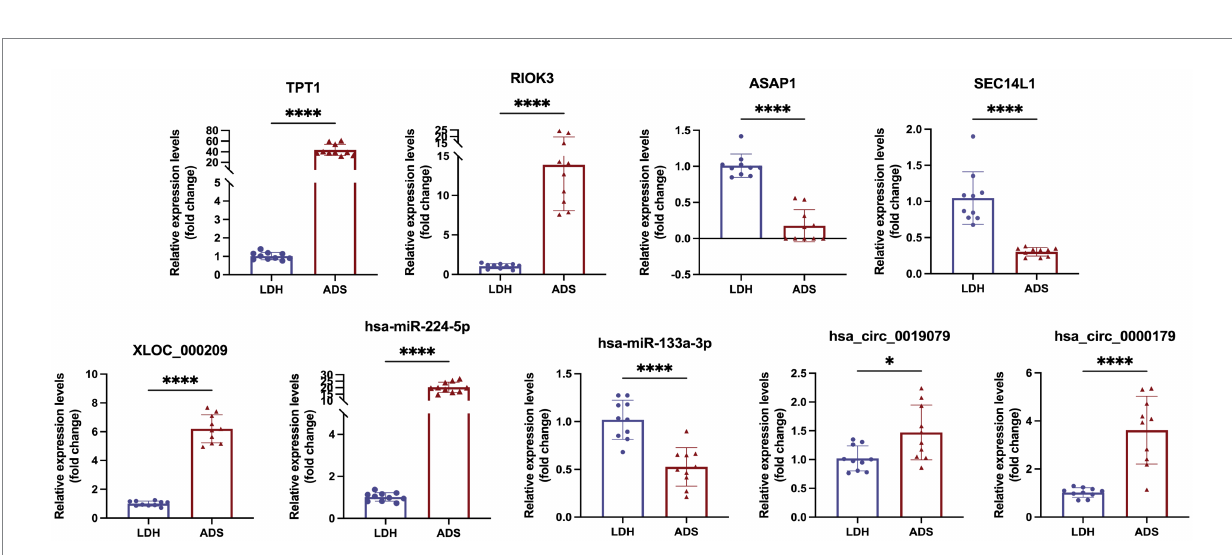
FIGURE 10 Validation for the expression of significant transcripts by quantitative RT-PCR (mean ± SD , n = 10; **** P <0.0001, * P <0.05 compared with the LDH